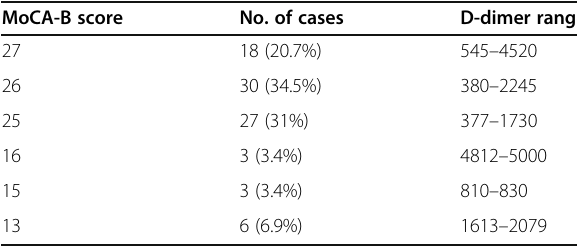
Table 3 Case numbers in different MoCA-B scores and